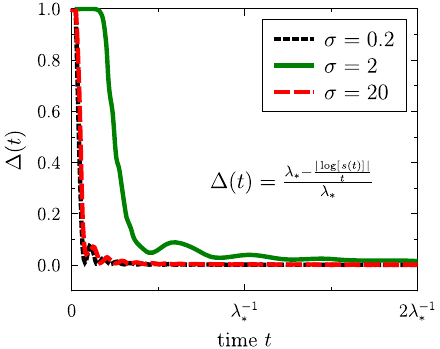
is sampled uniformly in k